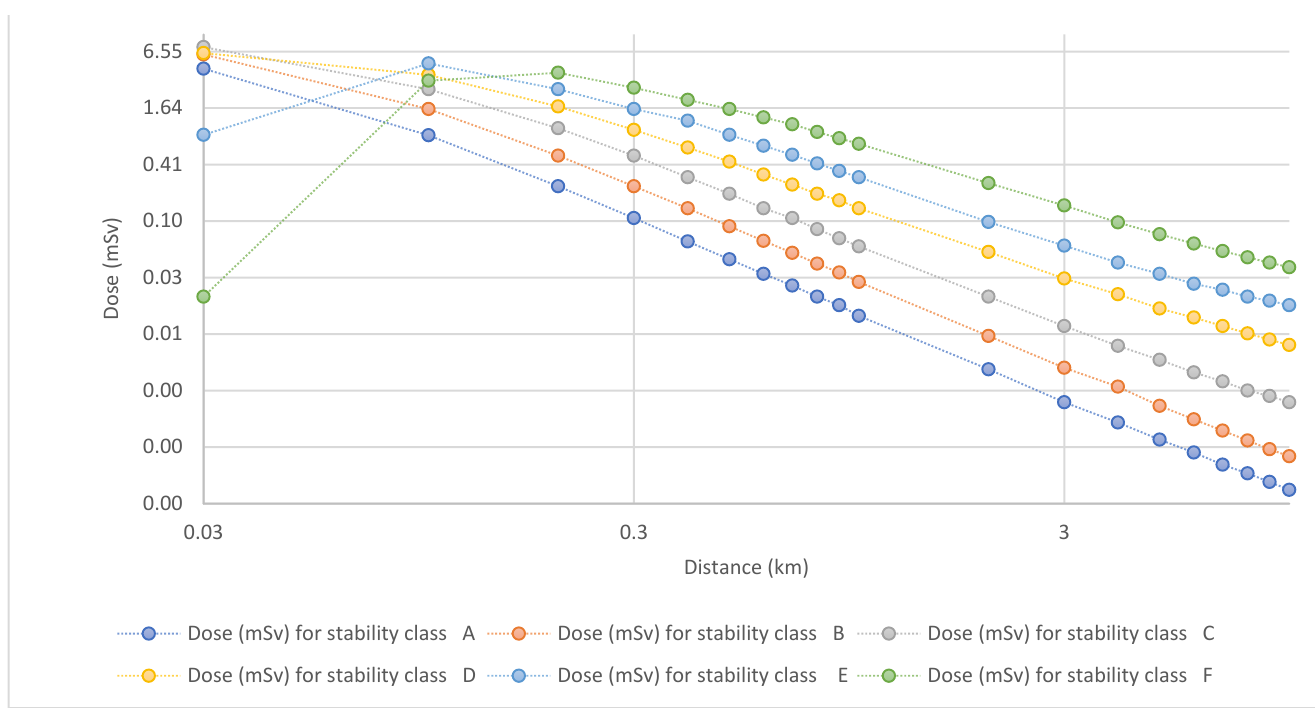
Figure 7. Dose from the HotSpot code for activity concentration above 1000 Bq/kg.